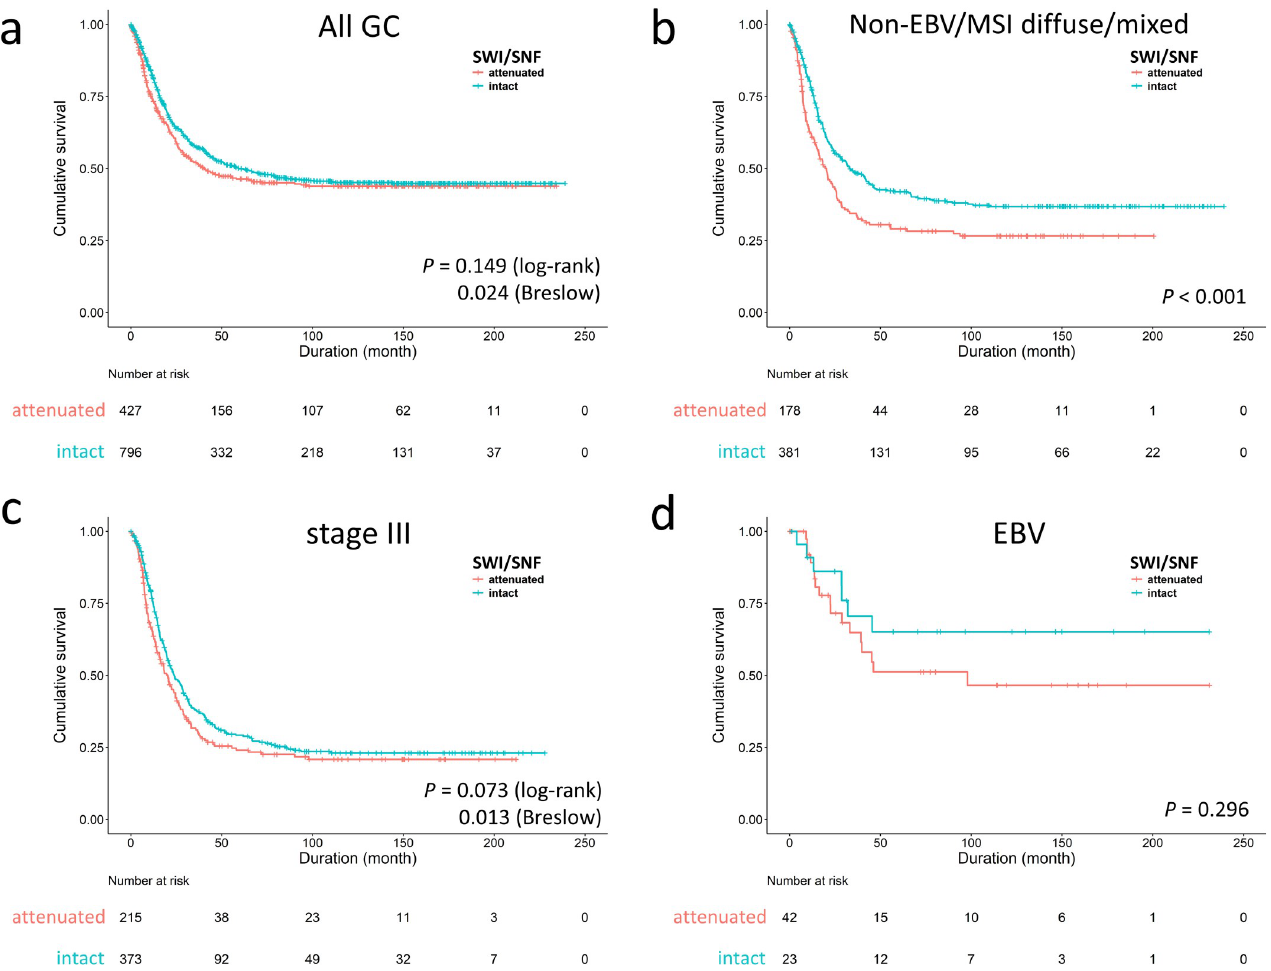
Fig 2. Survival analysis of SWI/SNF-attenuated gastric cancer (GC). a. The inferior outcome of SWI/SNF-attenuated GCs occurred in the early time period ( P = 0.024 in Breslow test). The survival impact of SWI/SNF-attenuated GC was significant in the non-EBV/MSI diffuse/mixed subtype (b) and stage III disease (c) . d. In EBV-associated GC, attenuated SWI/SNF expression had a trend toward poor prognosis ( P = 0.296).